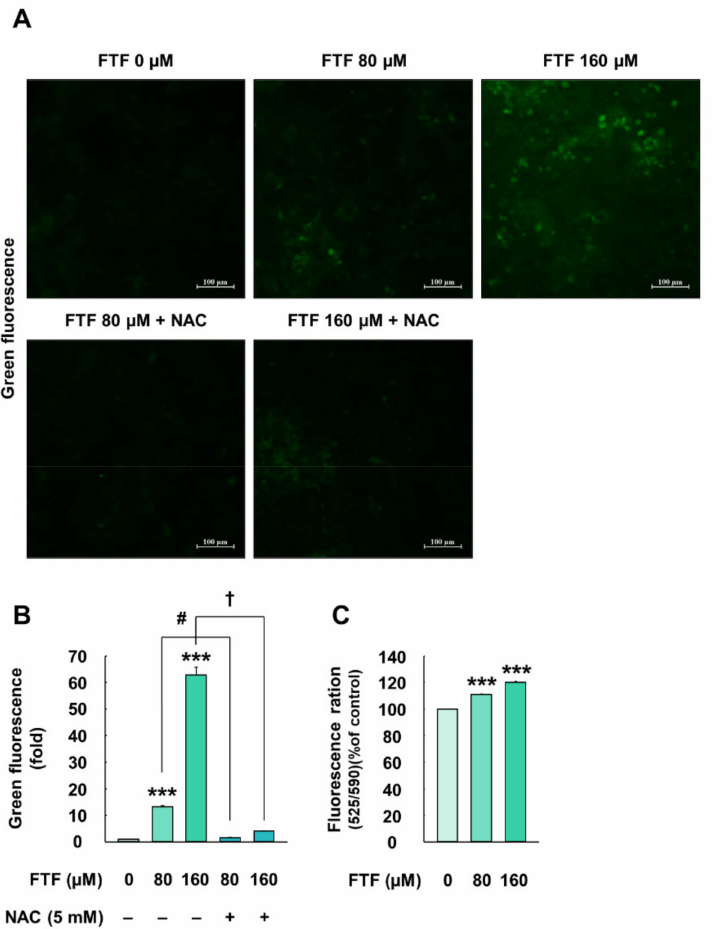
Figure 3. Effects of FTF on cellular ROS production and mitochondria membrane potential in HepG2 cells: ( A ) fluorescence image of ROS generation and ( B ) quantification of the green fluorescence area in HepG2 cells. The magnification of the image was 200 × . The cells were treated with 80 and 160 µ M FTF for 24 h with 5 mM NAC pretreatment for 1 h ( n = 3 wells per group); ( C ) fluorescence ratio of JC-10 monomeric form (525 nm) to JC-10 aggregate form (590 nm) in HepG2 cells. The magnification of the image was 200 × . The cells were treated with 80 and 160 µ M FTF for 24 h ( n = 3 wells per group). Images are representative of three independent experiments. The results are expressed as the mean ± SEM and statistically significant difference, as compared to the control (DMSO), is indicated as *** P < 0.001. # P < 0.05 and † P < 0.05 indicate a significant difference, compared to